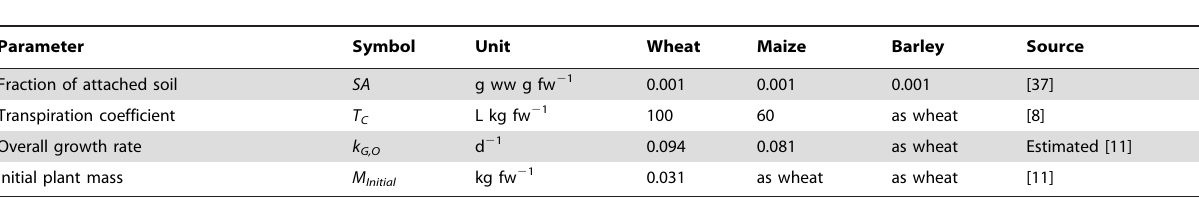
Table 3. Estimated plant parameters (initial plant mass normalized to an area of 1 m 2 ).